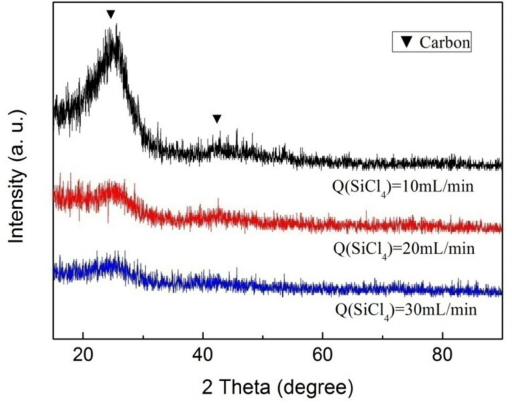
Figure 4. X-ray powder diffraction (XRD) patterns of SiBN ceramic deposited at various SiCl 4 flow rates.